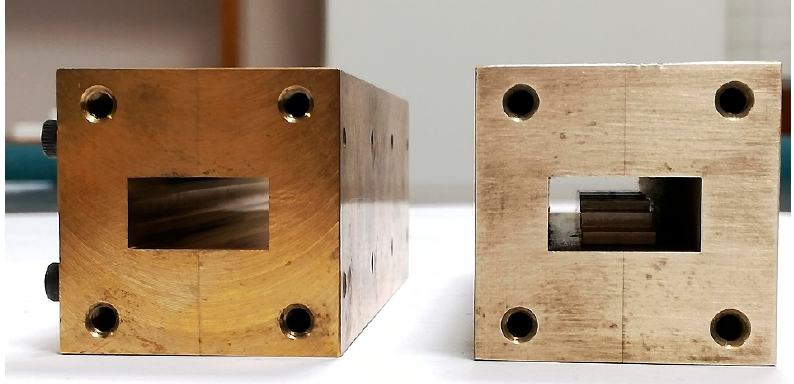
Figure 6. Photograph of one of the manufactured DPSs: reference waveguide ( left ) and shift waveguide ( right ).